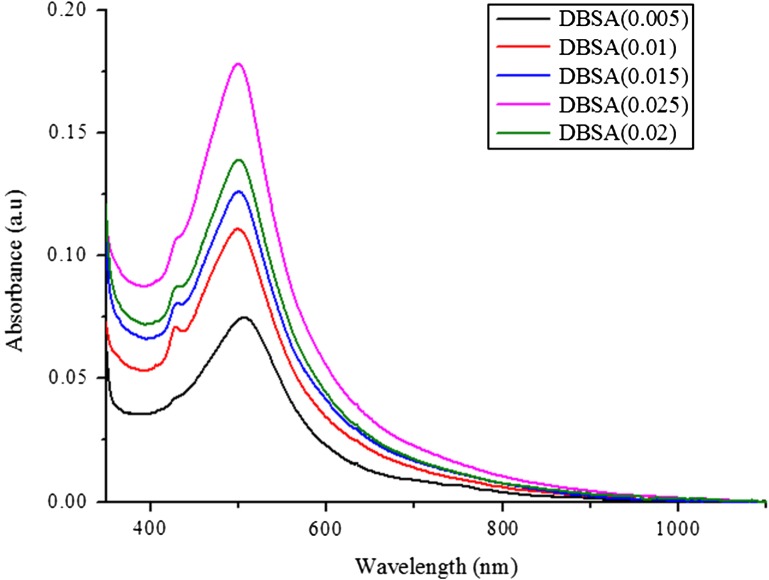
UV–vis spectra of BDSA doped PNVC–Ppy at varying concentrations of DBSA.